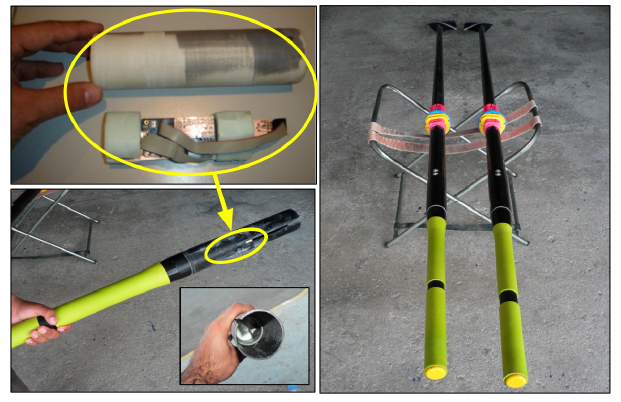
Figure 4. Mounting the mote inside the